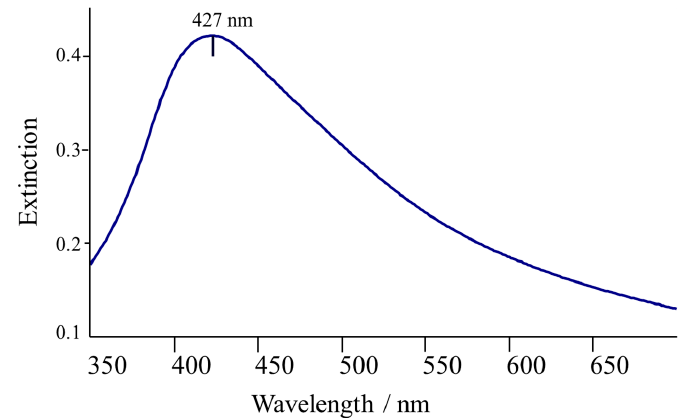
Figure 1. The UV-visible absorption spectrum of the AgNPs colloid. The absorption maximum is located at 427 nm.